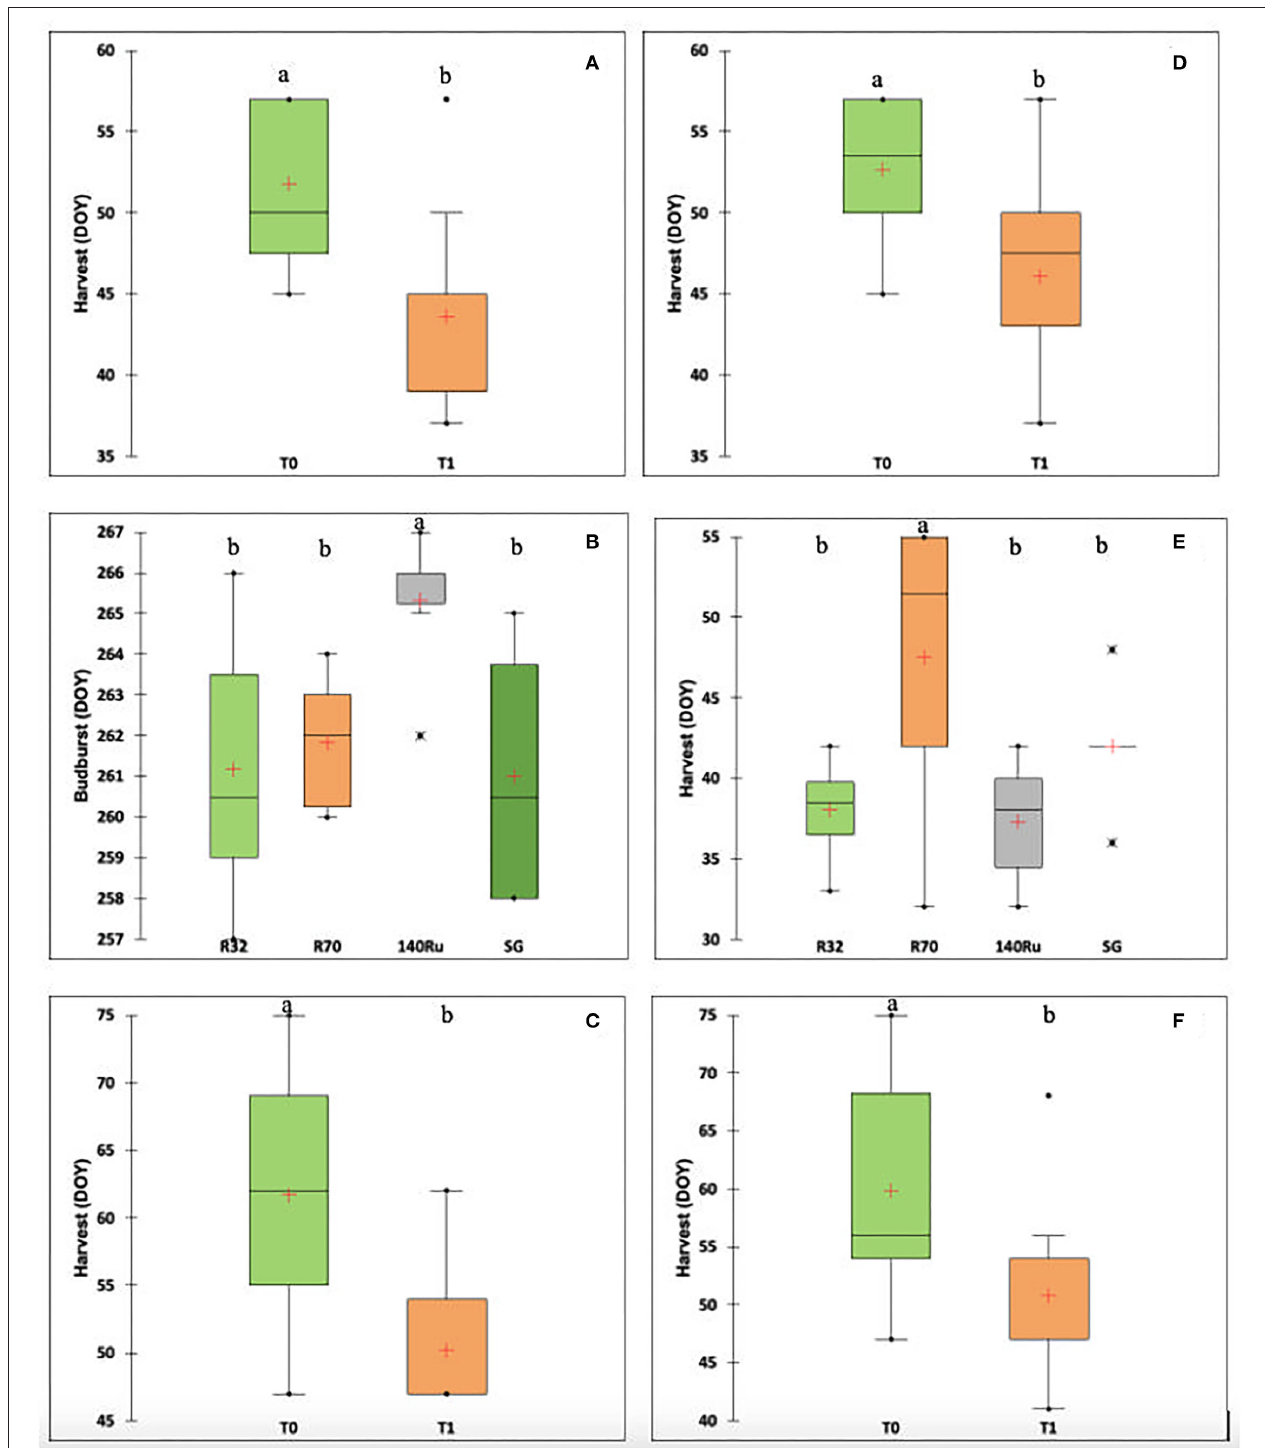
FIGURE 4 | Boxplots showing the distribution of phenological variables by the factor that explained the largest amount of variance for each cultivar and season according to Table 2 . (A) Harvest (Days of the year, DOY) based on to irrigation, cv CS, 2018–2019 season; (B) Budburst (DOY) based on to rootstock, cv CS, 2019–2020 season; (C) Harvest (DOY) based on to irrigation, cv CS, 2020–2021 season; (D) Harvest (DOY) based on to irrigation, cv Sy, 2018–2019 season (E) Harvest (DOY) based on to rootstock, cv Sy, 2019–2020 season; and (F) Harvest (DOY) based on to irrigation, cv Sy, 2020–2021 season. Within each figure, different lowercase letters present significant differences ( p -value <